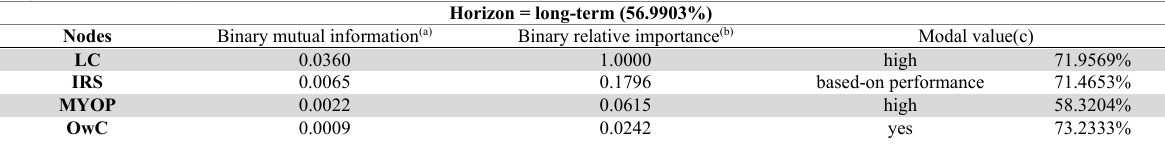
Horizon = long-term (56.9903%)